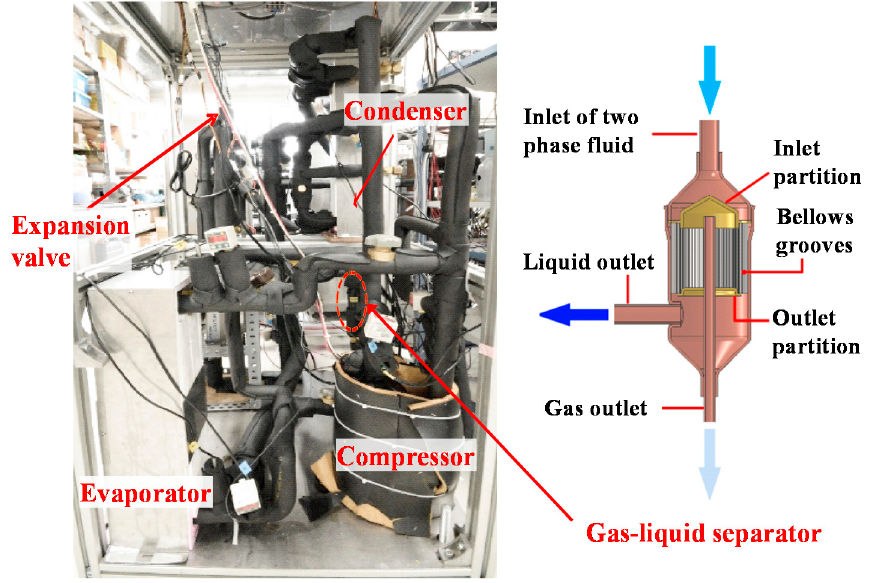
Figure 3. Picture of the experimental setup.